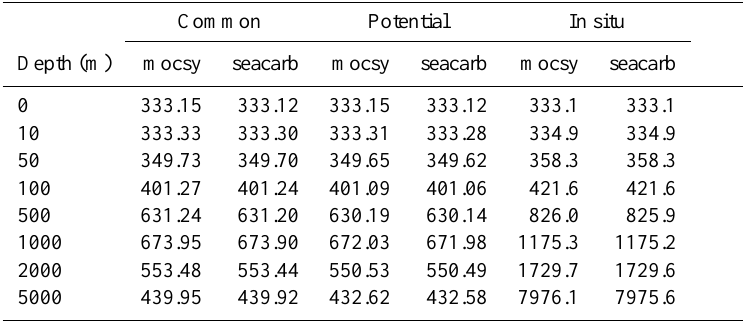
Table 10. Oceanic p CO 2a from three approaches b in two packages. Common